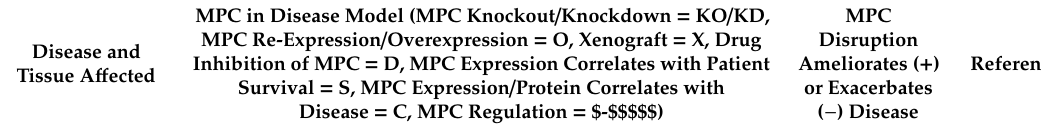
Table 1. The MPC in various disease